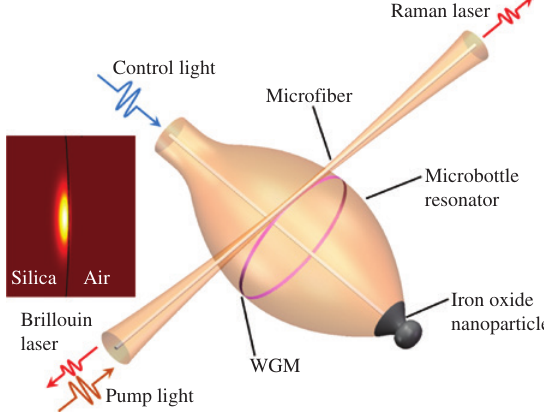
Figure 1: Schematic of the tunable Brillouin laser and Raman laser in the ultrahigh- Q hybrid microbottle resonator. The inset is the fundamental mode field distribution of the microbottle resonator with a diameter of 114 μ